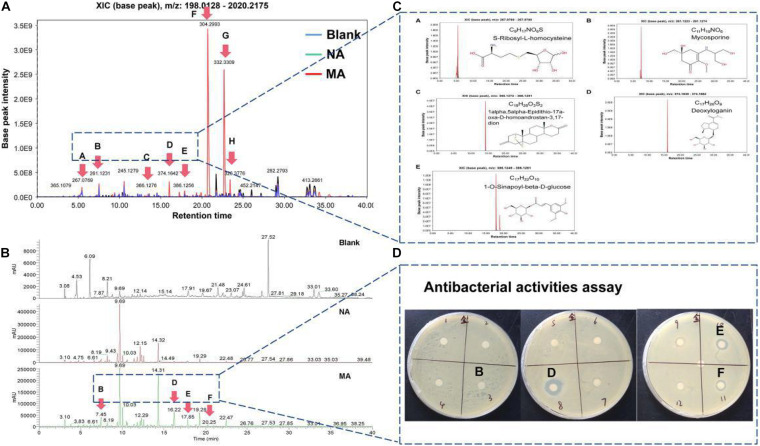
Metabolic profiles of ethyl acetate extracted crudes between the wild-type strain (NA) and mutant strain (MA). (A) TIC (total ion chromatogram) of the NA, MA, and blank control. (B) XIC (extracted ion chromatogram) of the MA. (C) Putative molecular formulas and structures matched to the online database. (D) Antibacterial activity assay results.